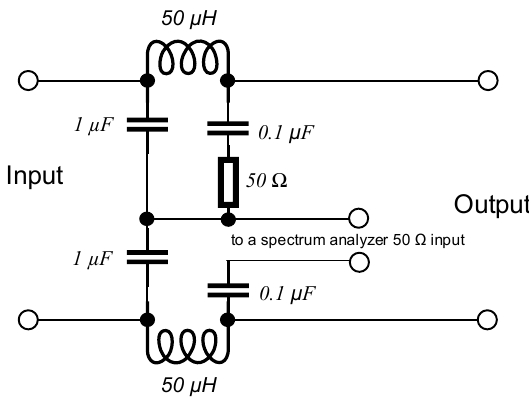
Figure 5. A schematic diagram of the home-made LISN used in the experiments.